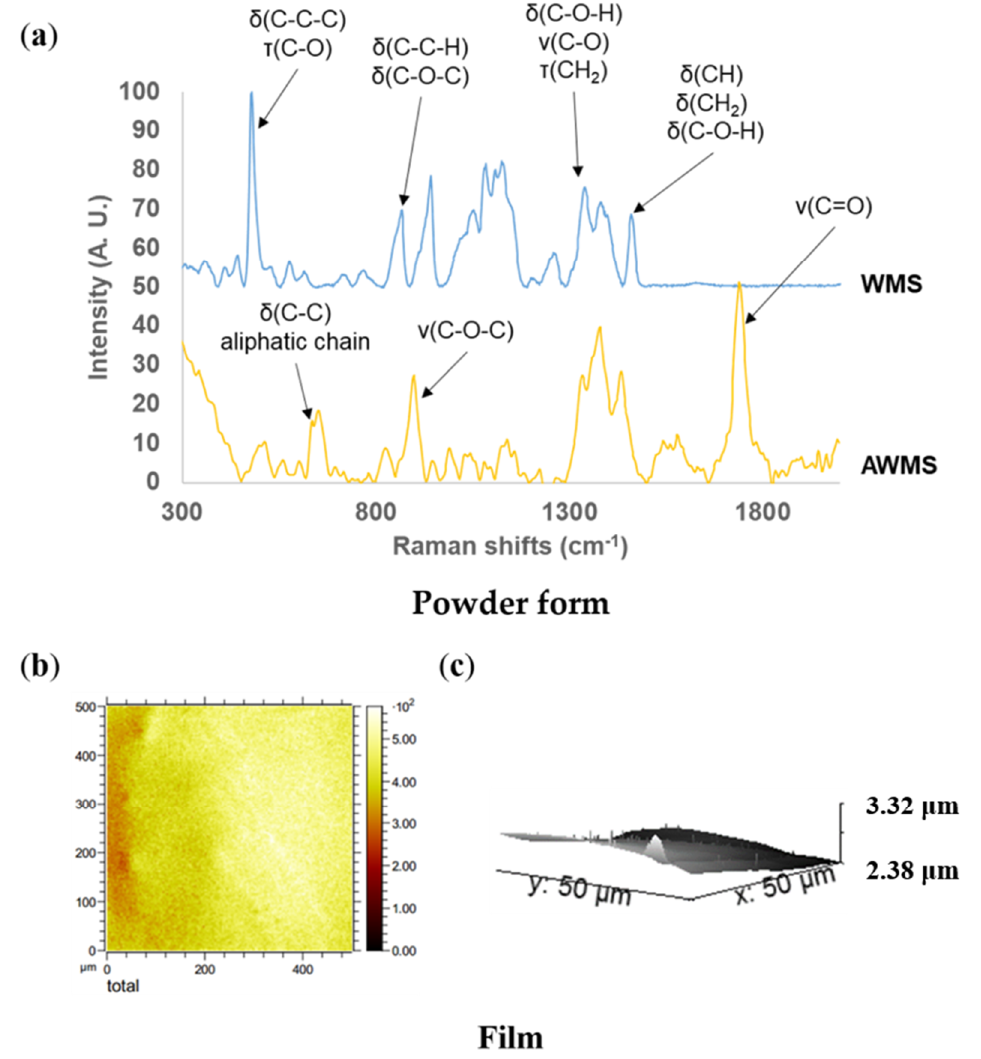
Figure 4. Surface characterization of acetylated waxy maize starch (DS 2.6). ( a ) Raman spectra of WMS and AWMS, ( b ) TOF-SIMS 2D mapping of the acetate fragment in AWMS, ( c ) AFM topography image of AWMS.